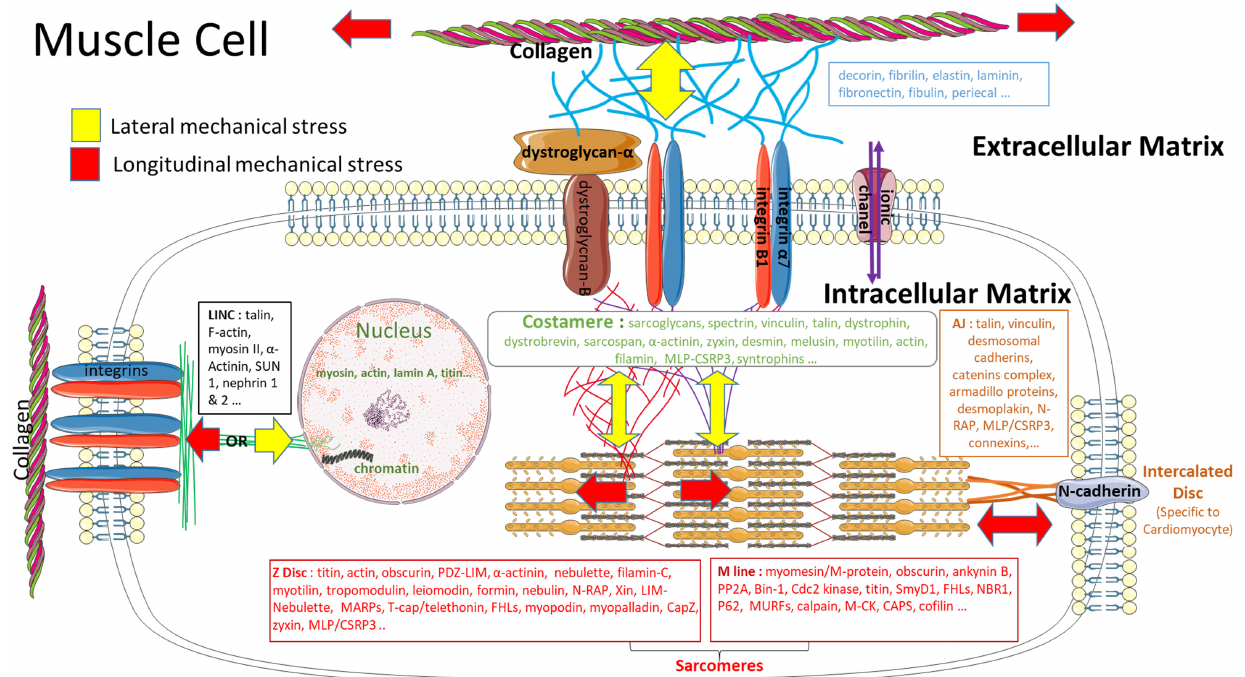
Figure 1 : Relationship between the costamere and the sarcolemma, the extracellular matrix and the sarcolemma and, the sarcolemma and the nucleus. The drawings of costamere zone, extracellular zone and the nucleus zone are inspired from Samarel et al. [100], Nishimura [77], Wang et al. [75] and Henderson et al. [101], respectively. Red arrows: longitudinal force transmission. Yellow arrows: Lateral force transmission. An example is shown on the possible mechanical stress induced by an external pressure or internal sarcomeric contraction.